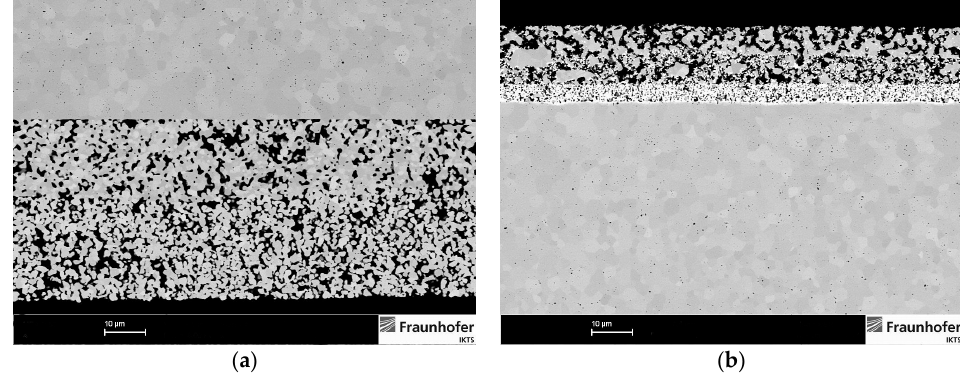
Figure 9. Microstructure of the bi-layer LSMM’/10Sc1CeSZ air electrode ( a ) and the multilayer Ni/CGO fuel electrode; ( b ) after reduction in hydrogen before starting the cell operation. fuel electrode; ( b ) after reduction in hydrogen before starting the cell